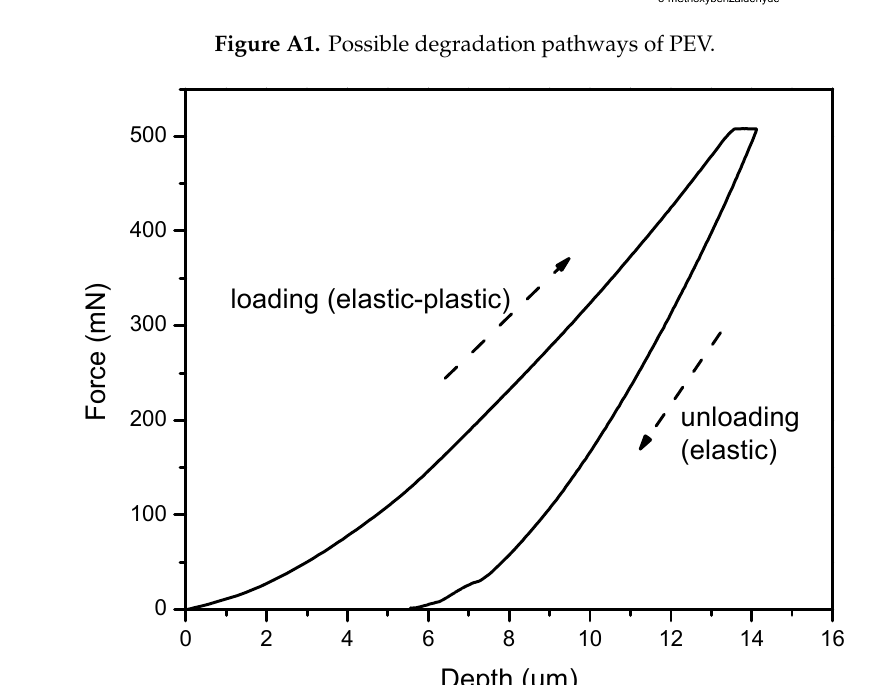
Figure A2. Indicative load–displacement curve of PEV obtained from the nanoindentation test.